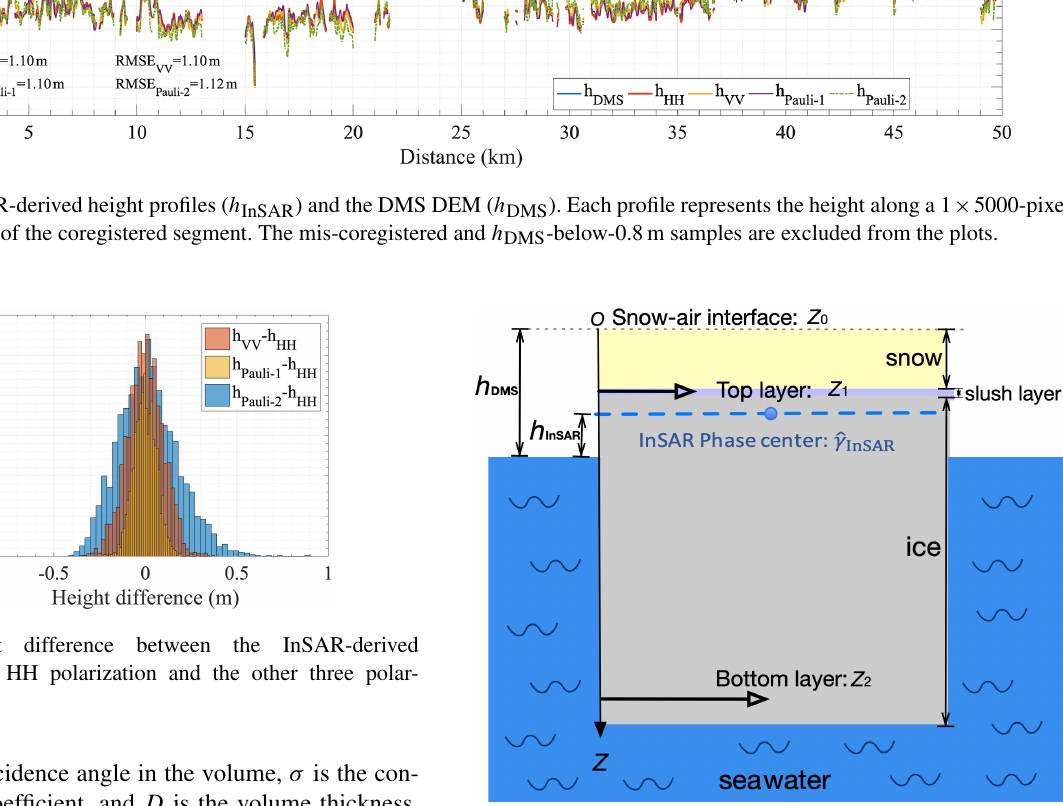
Figure 7. Schematic of the proposed two-layer-plus-volume model for sea